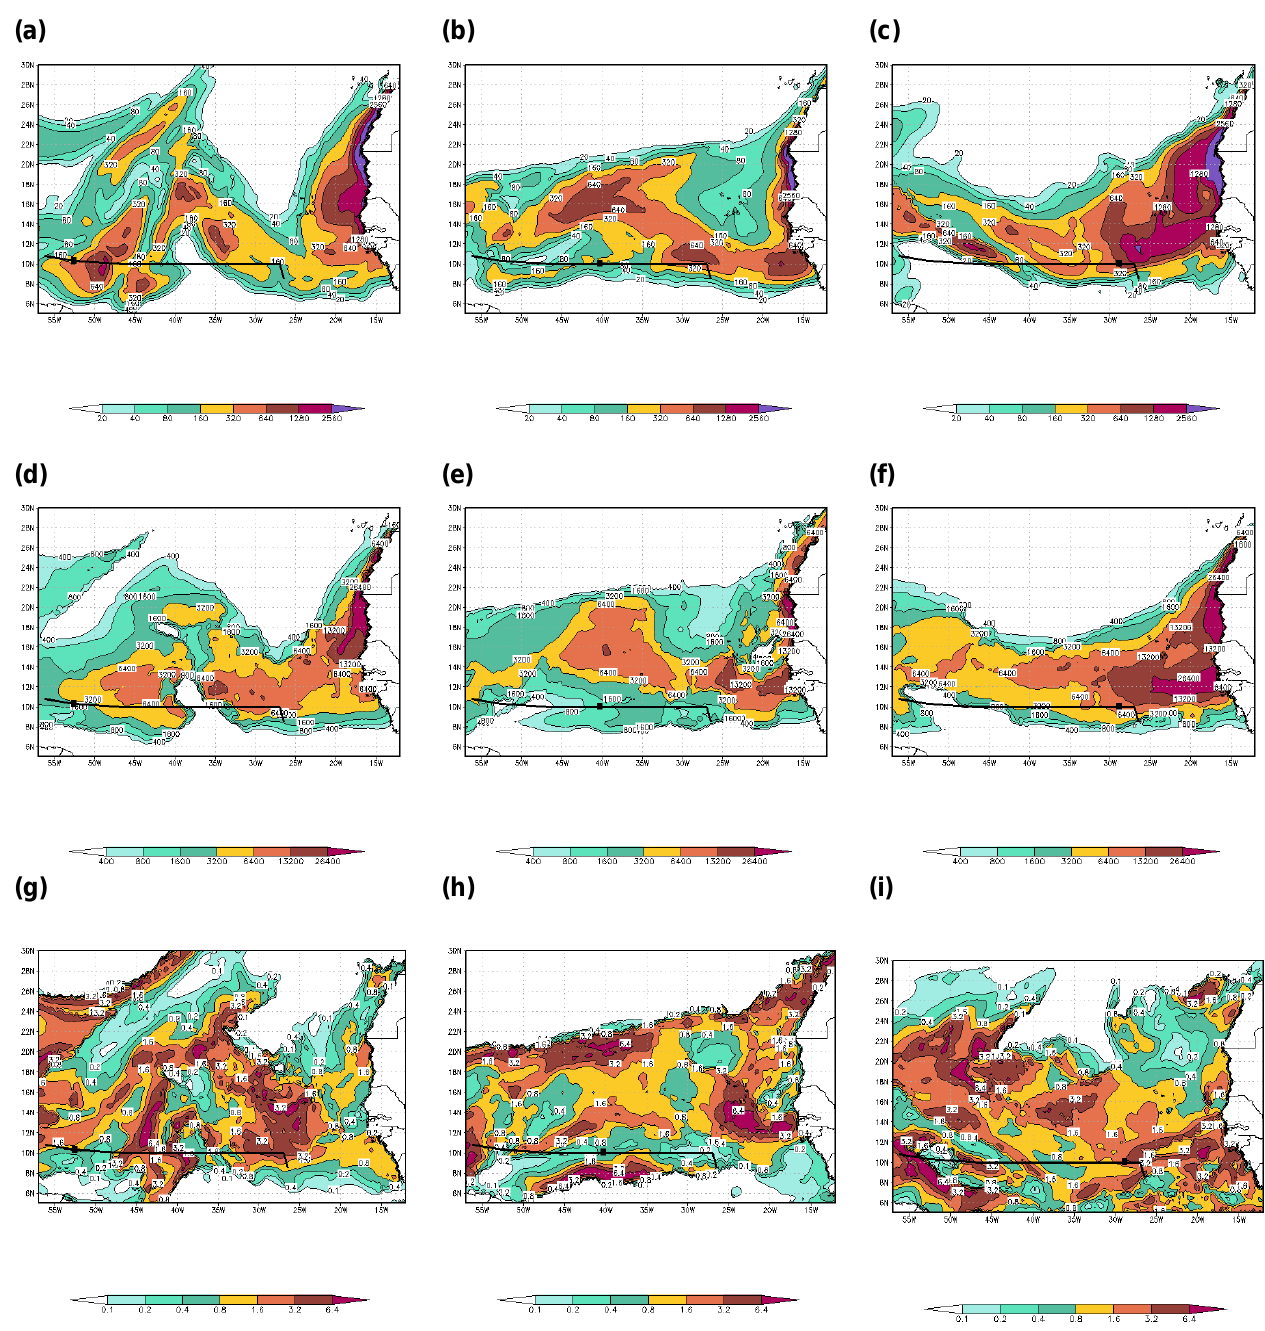
Fig. 3. Spatial and temporal features of simulated dust-related fields. (a–c) : the instantaneous total iron concentration in dust T (ngm − 3 ) at Figure 3. Spatial and temporal features of simulated dust-related fields. (a)-(c): the instantaneous 12:00UTC for 17, 21 and 25 October 2002; (d–f) : the same as in (a) but for the soluble iron concentration S (pg m − 3 ); (g–i) : the same as in total iron concentration in dust T (ng m -3 ) at 12:00 UTC for 17, 21 and 25 October 2002; (d)-(f): the (a) but for the iron solubility s % same as in (a) but for the soluble iron concentration S (pg m -3 ); (g)-(i): the same as in (a) but for the s iron solubility %